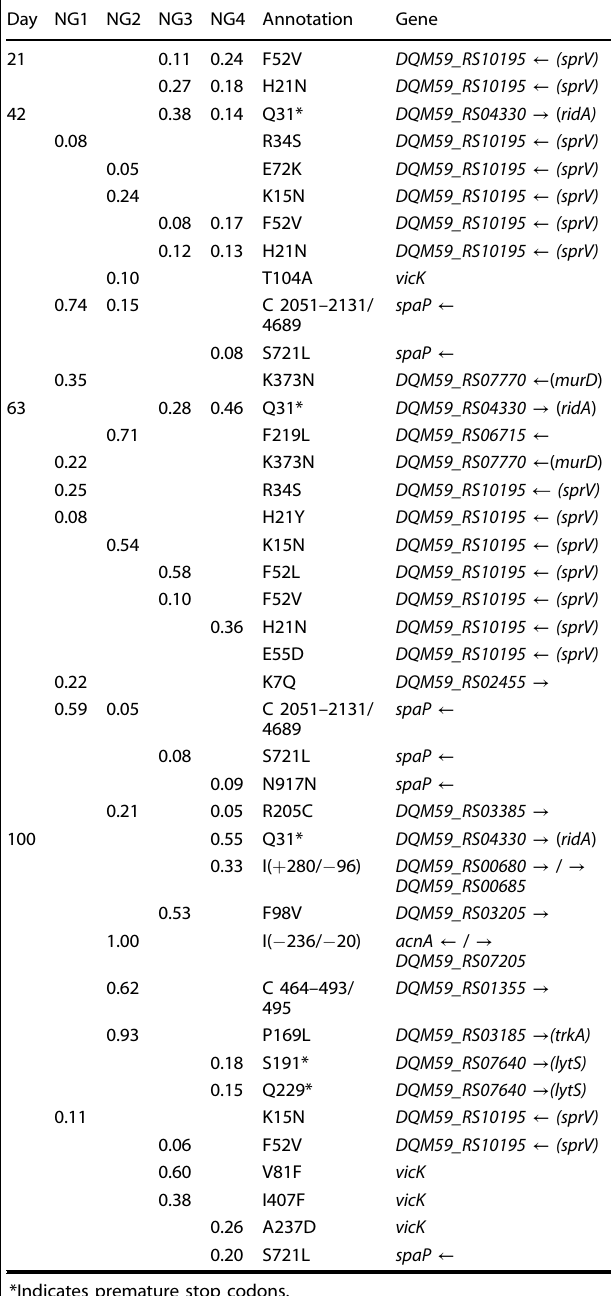
*Indicates premature stop codons. C indicates in the coding region. I indicates intergenic